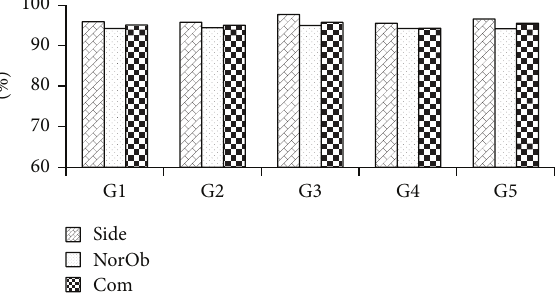
Figure 12: CCRs of group covariate factors for MMUGait Covariate DB.